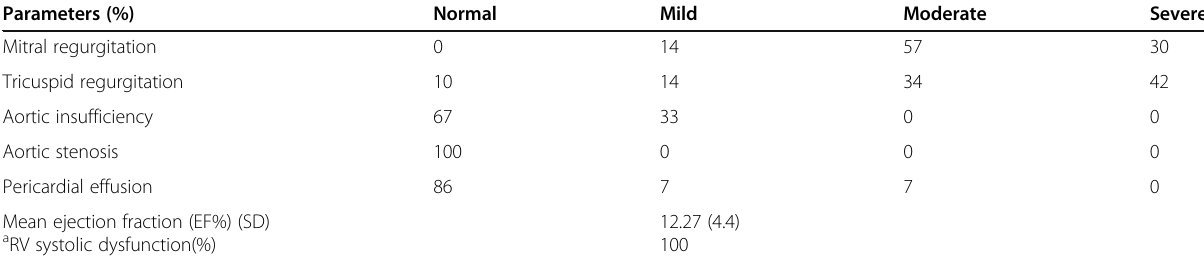
Table 2 Echocardiographic findings of cardiomyopathic hearts Parameters (%)